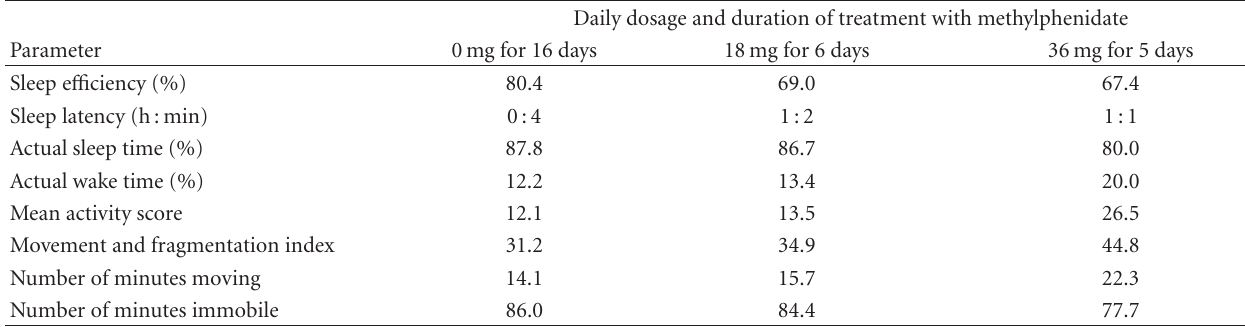
Table 1: Mean values for actigraphic parameters before and during treatment with methylphenidate. Daily dosage and duration of treatment with